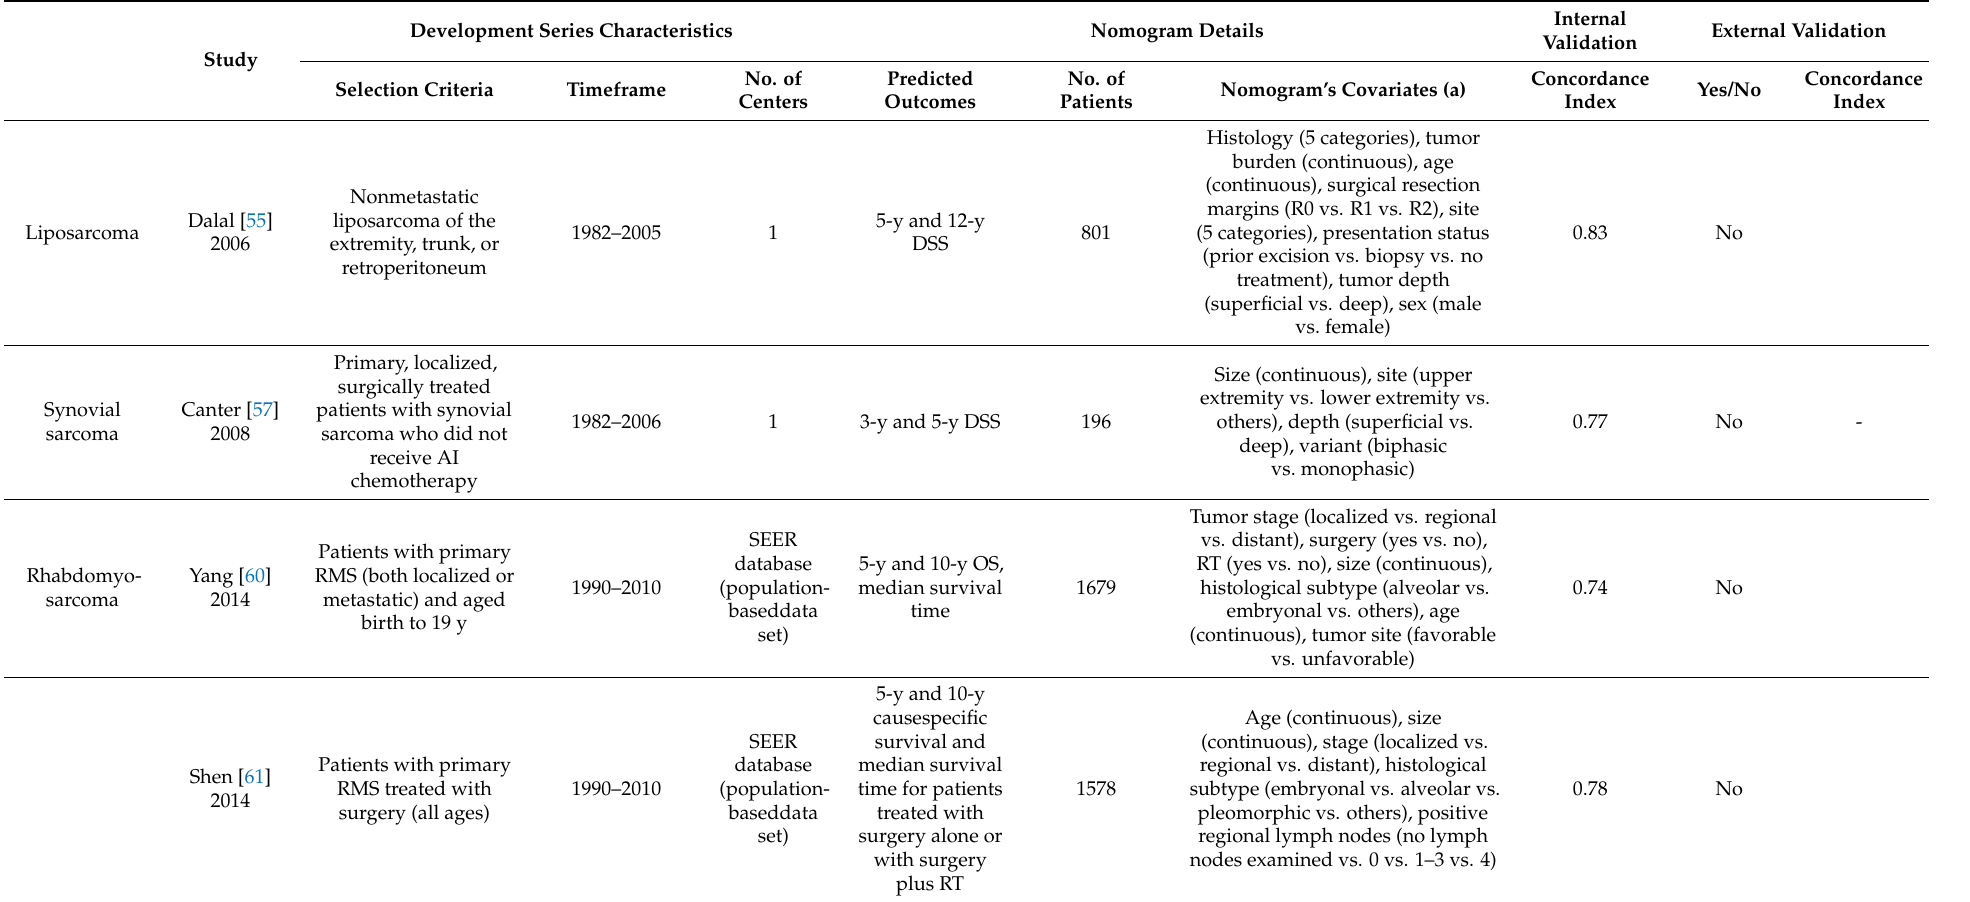
Table 3. Histology-Specific and Histology-Specific and Site-Specific Nomograms for Patients With